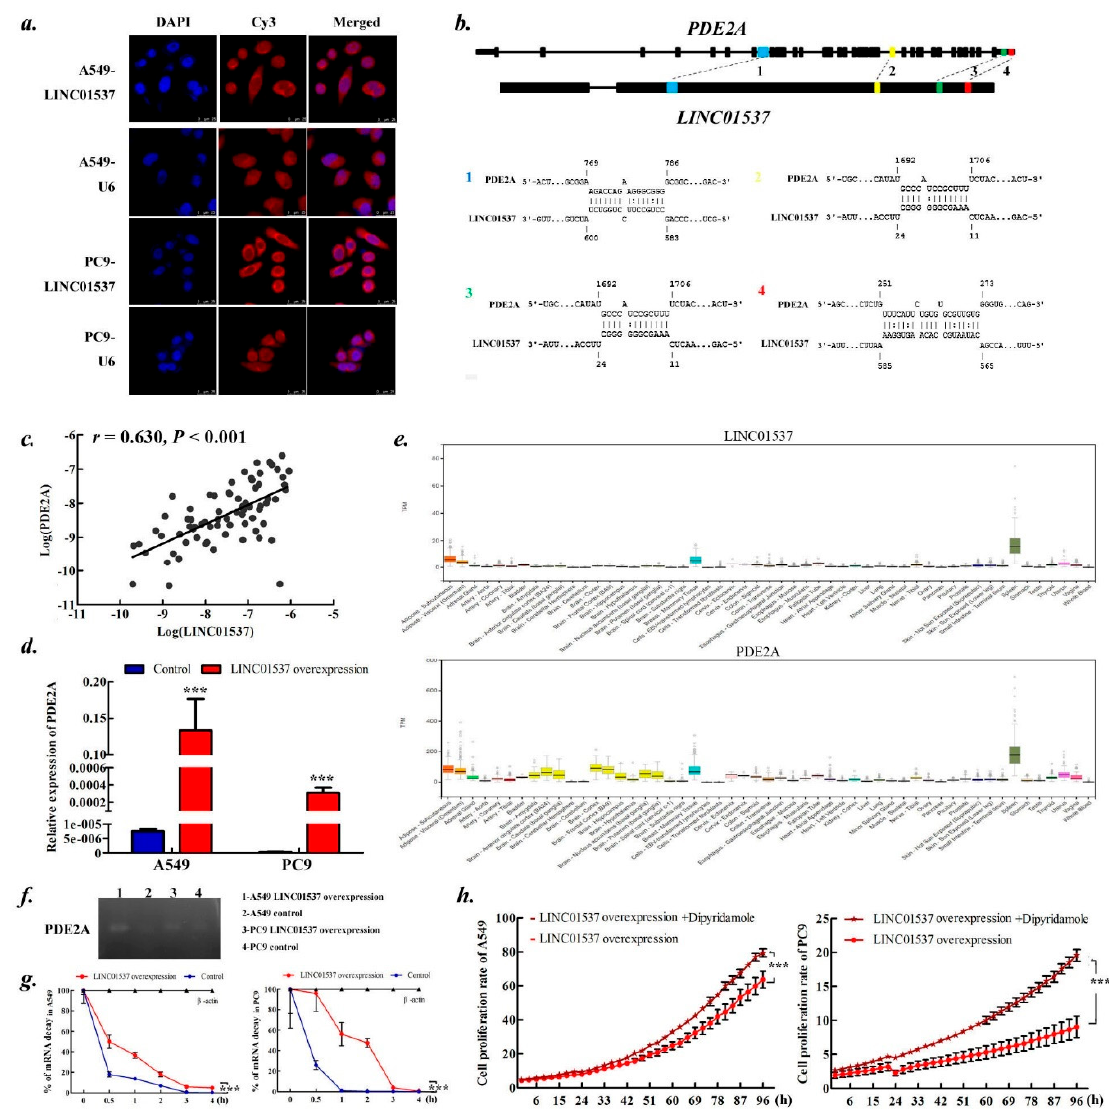
Figure 5. LINC01537 upregulates PDE2A via RNA–RNA interaction. ( a ) . Fluorescence in situ hybridization of LINC01537 in A549 and PC9 cells. DAPI staining of DNA (left), fluorescence in situ hybridization (FISH) probes of LINC01537 (middle) and merged (right). The small nuclear RNA U6 was tested as a positive control for nuclear localization. ( b ) . Schematic representation of the predicted RNA–RNA interaction between LINC01537 and the exons of PDE2A. ( c ) . The correlation between LINC01537 expression and PDE2A expression in lung cancer tissues. Purple dot corresponds to log (LINC01537) expression in x-axis and log(PDE2A) expression in y-axis. r, p , calculated by the Pearson correlation analysis. ( d ) . The qPCR was performed to determine PDE2A expression. ( e ) . LINC01537 and PDE2A expression in 53 tissues from GTEx RNA-seq. ( f, g ) . The RPA (f) and mRNA stability tests ( g ) were used to assess the role of LINC01537 on protecting PDE2A mRNA. The β -actin was tested as a control. h. Cell proliferation in response to dipyridamole treatment. Bar height ( d ) or Circle dot ( g, h ) on line corresponds to the mean, and error bars represent the SD for five biological replicates. *** p < 0.001, calculated by the two-way ANOVA test.